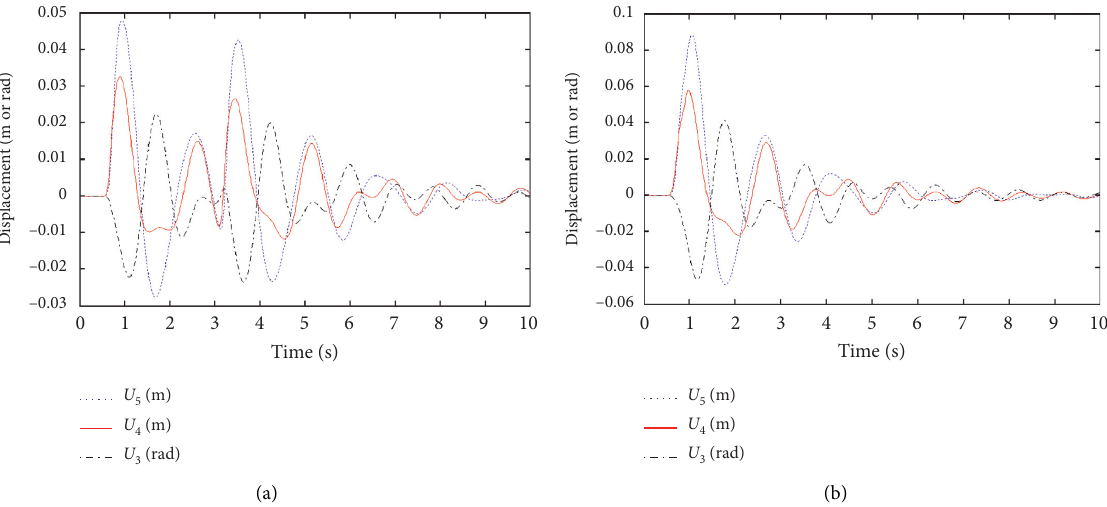
of the half vehicle system while the excitation is bump road inputs. The vector U n